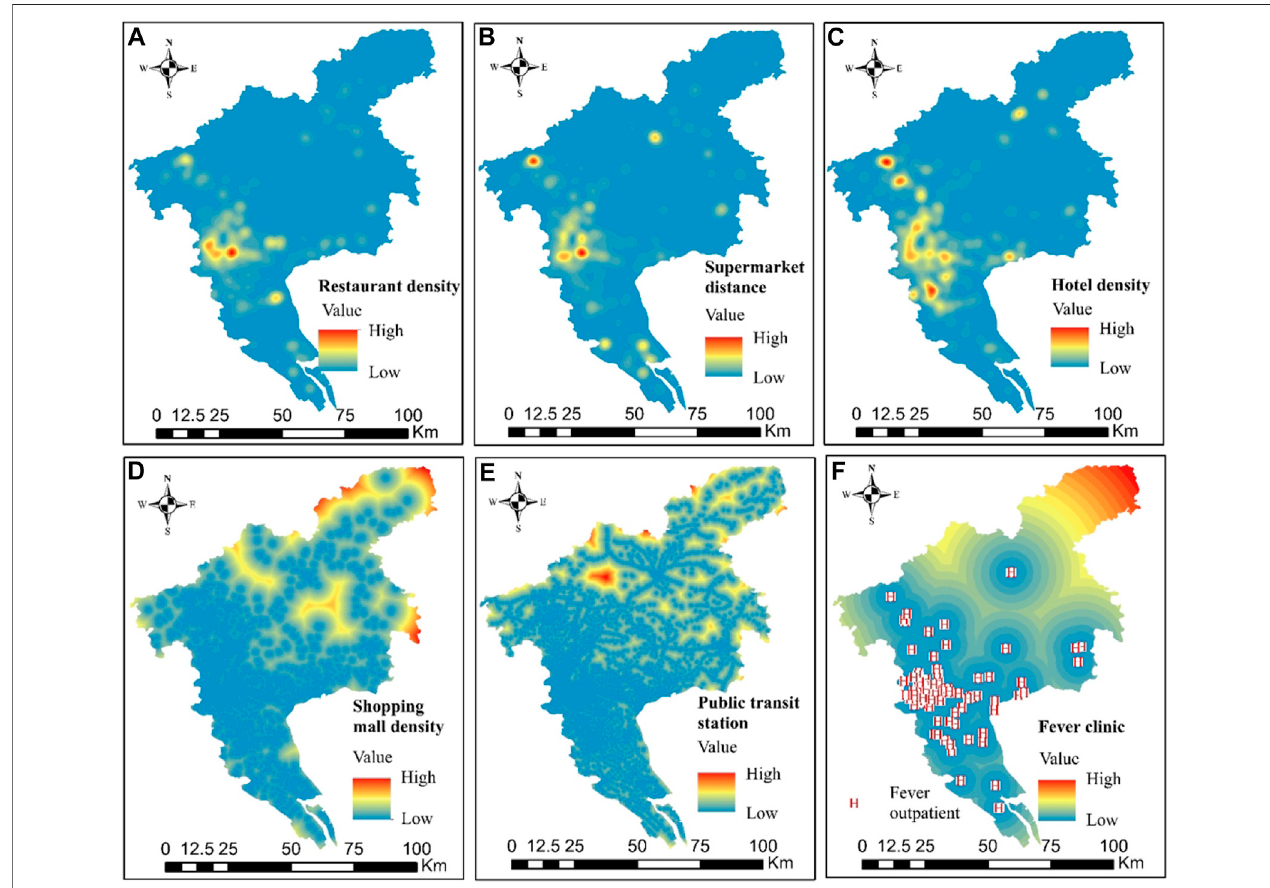
FIGURE2| POIdatapreprocessingresults[ (A – F )areCateringdensity,Marketdistance,Hoteldensity,Quotienthyperdensity,Traf fi cdensity,andFeveroutpatient distance of the spatiotemporal geographic epidemiological data of Guangzhou; the color in the fi gure ranges from blue to red, indicating density and distance value ranges from low to